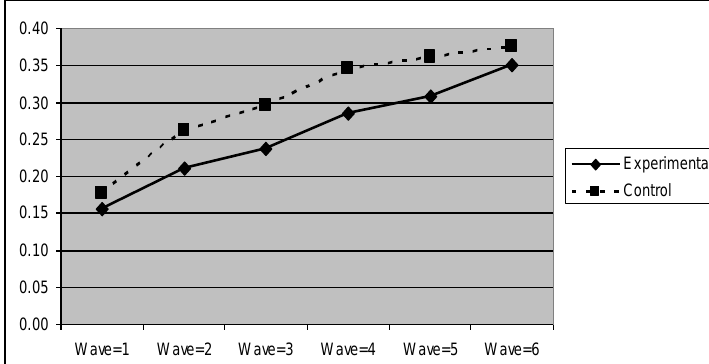
FIGURE 16 . Growth trajectories of the experimental group (Tier 1 participants who perceived the program as effective) and control group using the composite score of psychotropic drug use as the outcome indicator.